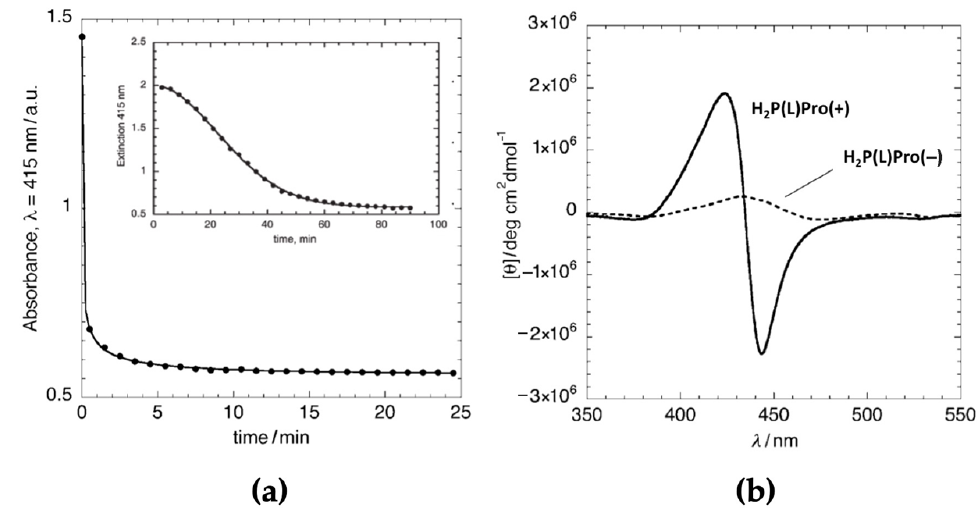
Figure 2. ( a ) Kinetic profile (UV-Vis intensity variation of Soret band) of H 2 P(L)Pro(–) in EtOH/H 2 O 25/75 v:v. The inset reports the corresponding profile for the H 2 P(L)Pro(+) counterpart. ( b ) Comparison of the CD profiles of the porphyrin-free base derivatives. Adapted from [43], with permission from Wiley-VCH, Copyright © 2010, and from [41], with permission from the Royal Society of Chemistry, Copyright © 2005.